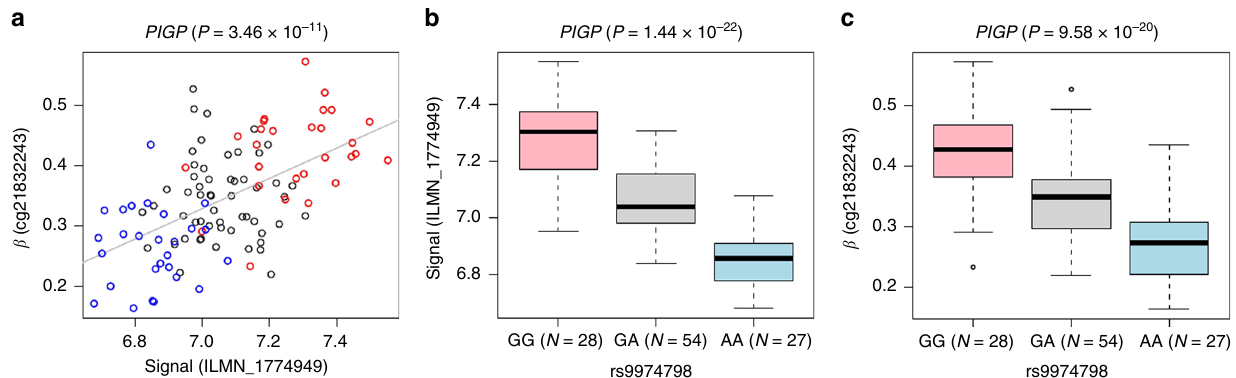
Fig. 3 Genetically driven correlation of CpG methylation with PIGP gene expression. The a correlation of PIGP 3 ′ -expression with methylation states of CpG cg21832243 in the promoter fl anking region (explained variance: 33.5%) is based on b a cis -eQTL (ILMN_1774949; P = 1.44 × 10 − 22 , explained variance: 57.1%) and c a cis -meQTL (cg21832243; P = 9.58 × 10 − 20 , explained variance: 50.9%) both driven by a shared SNP rs9974798. Previously, we reported an association of the SNP rs9305614 in the PIGP promoter with pharmacoresistance of seizures for the antiepileptic drug levetiracetam in a partial overlapping sample of TLE patients